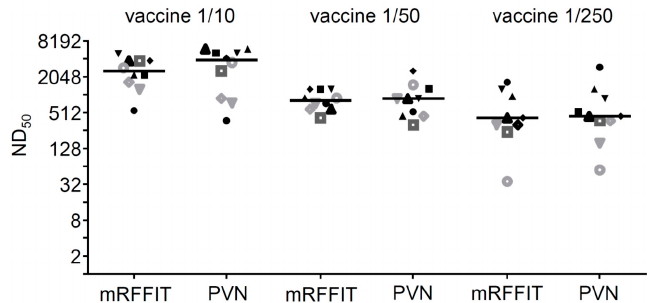
Figure 4. Comparison of the PVN test with the modified rapid fluorescent focus inhibition test (mRFFIT). Serum samples (not treated at 56 °C) from mice immunized with the indicated vaccine doses were analyzed with either the modified RFFIT or the PVN test. The PVN test was performed with CVS-11 G protein pseudotyped VSV* ∆ G(sNLuc) using the GFP reporter read-out. The neutralization dose 50% (ND 50 ) values for individual animals (represented by different symbols) and the mean values for each vaccine group ( n = 10) are shown.